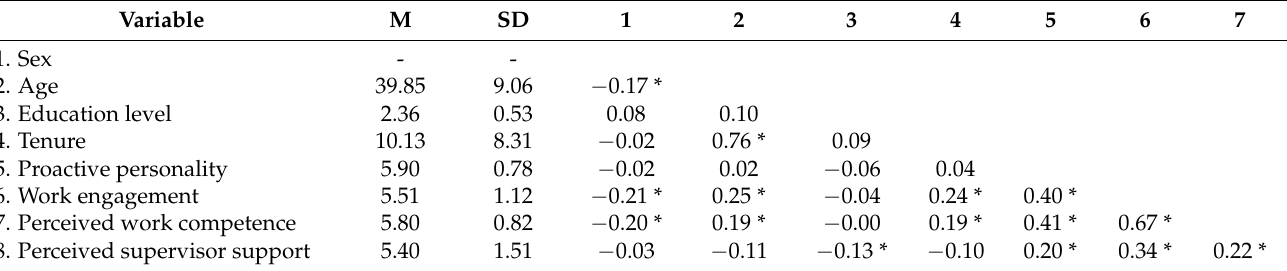
Table 1. Means, standard deviations, and correlations among variables ( n =